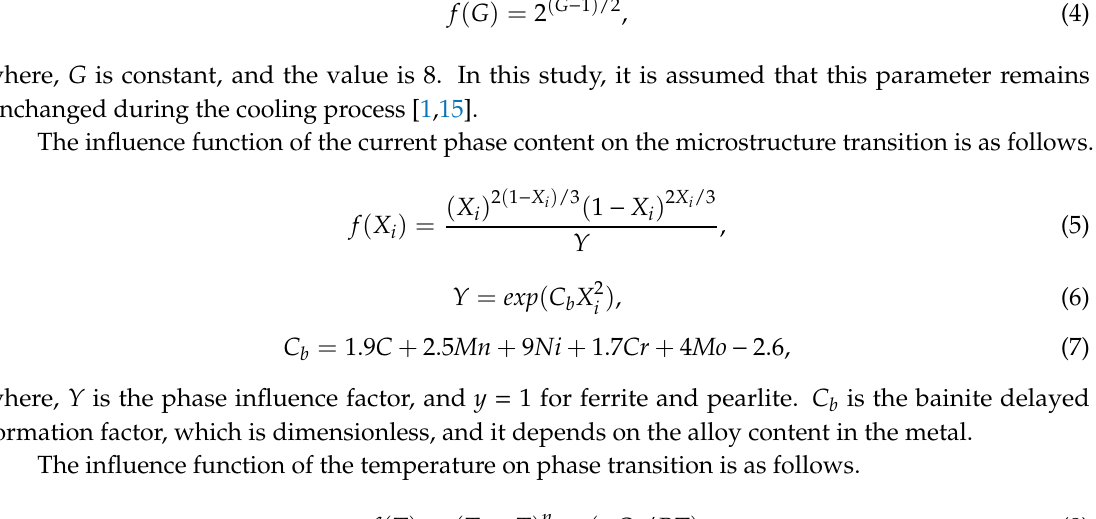
Figure 2. Grid model and analysis point location.